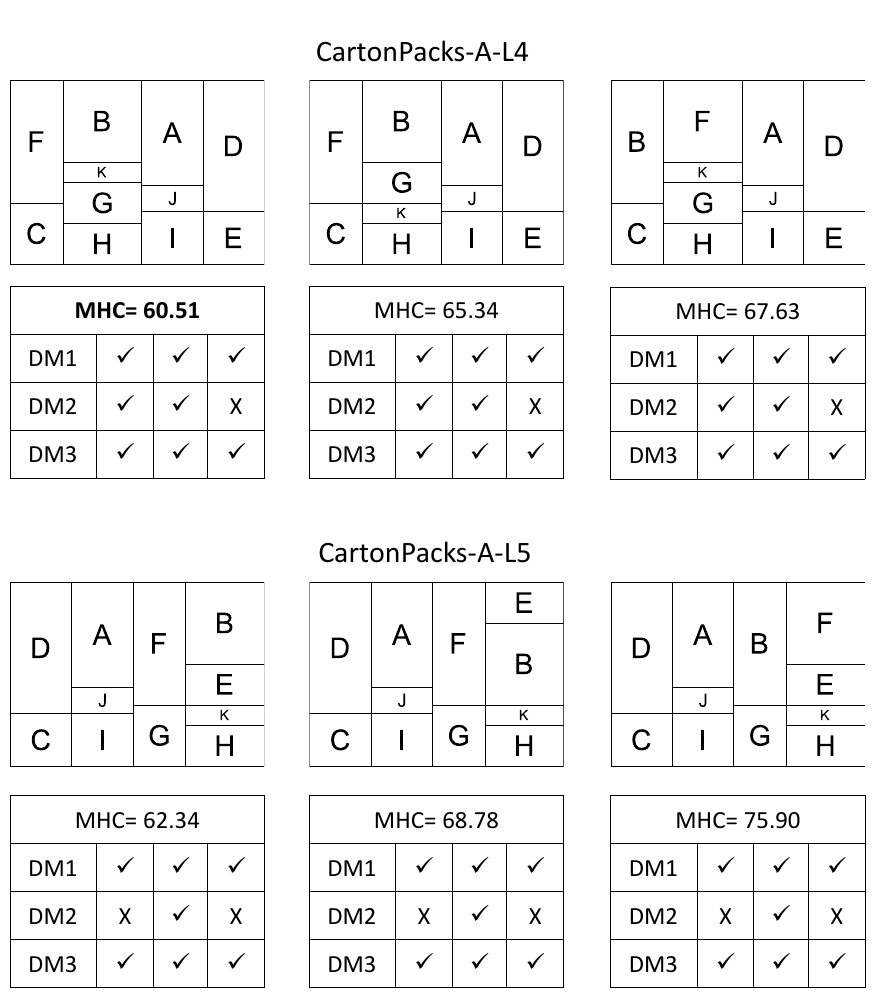
Figure 12. Best solutions found in Alternative launch 4 to 5 of CartonPacks